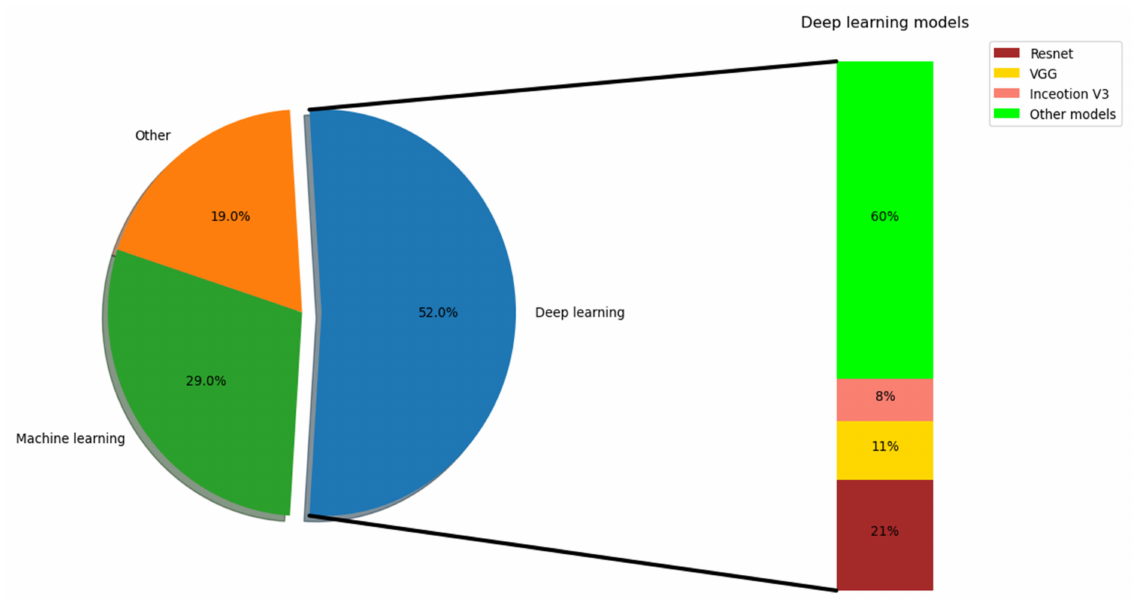
Figure 4. Contribution of various techniques to COVID-19